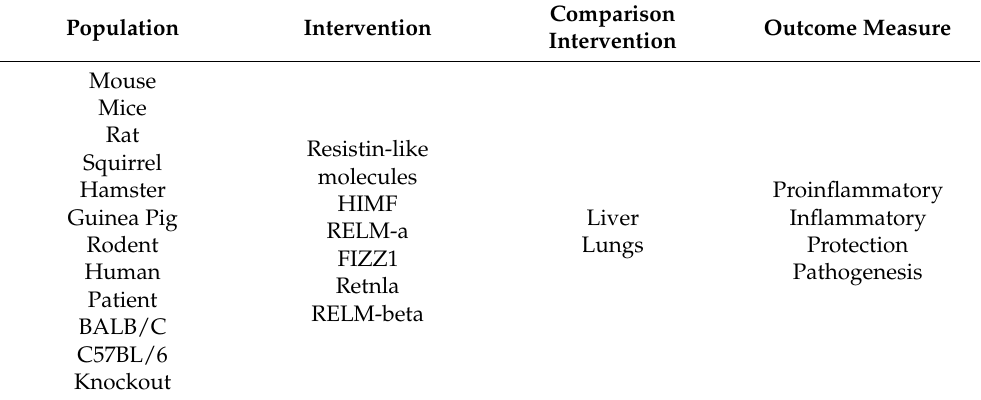
Table 1. Detailed keywords used in search strategy.